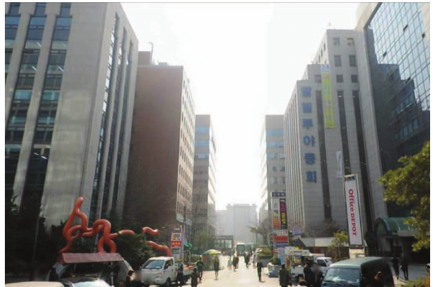
Figure 3: Measurement environments: urban street with 35–45 m high buildings and 30 m wide